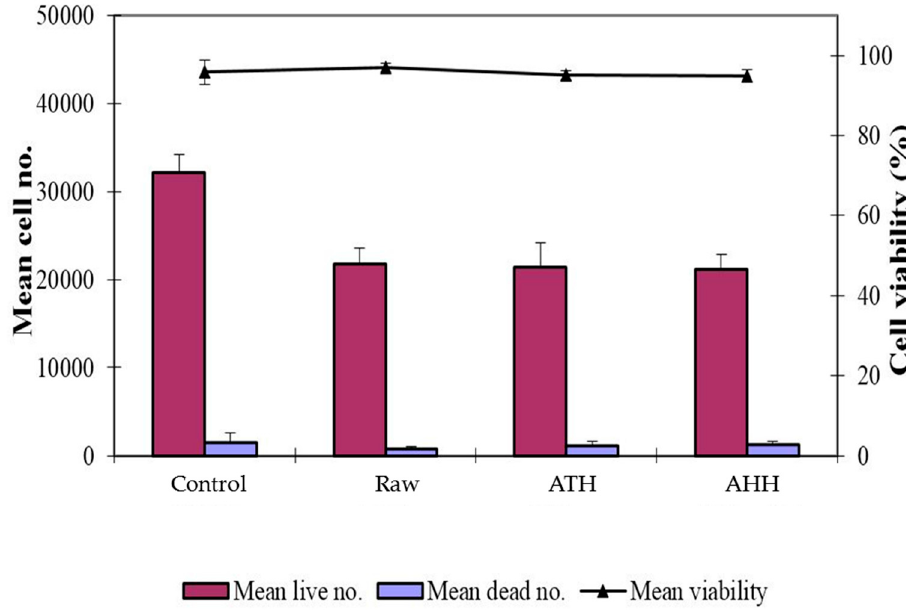
Figure 6. Toxicity study conducted on raw, ATH and AHH for 4 days.